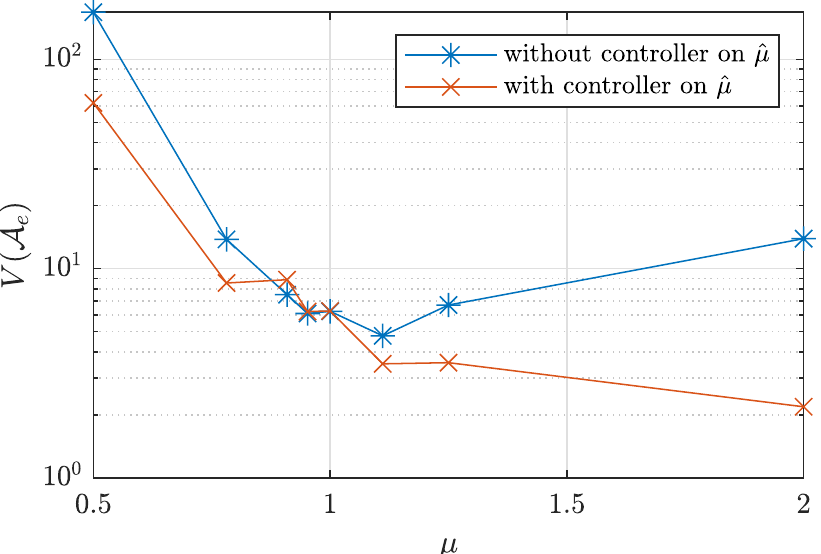
Figure 14. Dependence of the error attractor L 1 -volume on the parameter µ value for slave systems without and with a controller on ˆ µ , corresponding to slave systems (12) and (21), respectively.